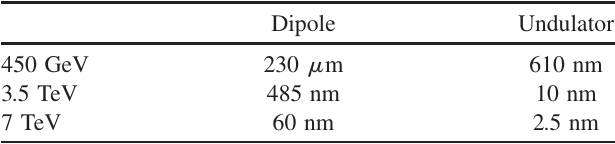
TABLE I. Expected central frequency of SR emission at different beam energies. The spectrum of the dipole is very broad; since the undulator has only 2 periods its spectrum is also rather broad. Thus, even when both are centered in the UV there is still substantial visible light